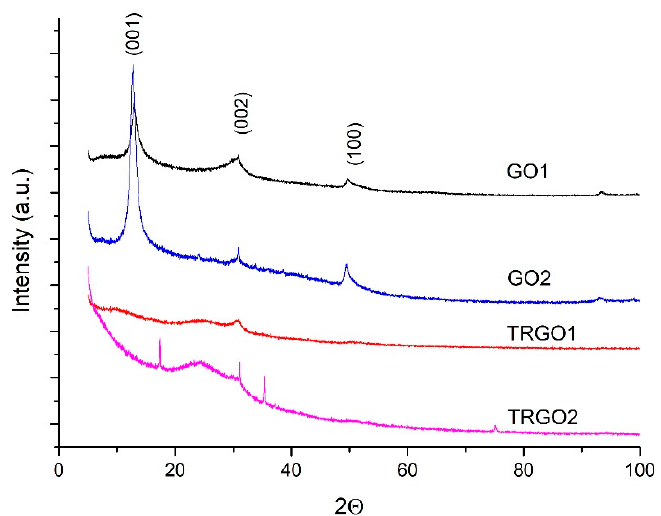
Figure A4. C1s spectra (XPS) of thermally reduced graphene oxide TRGO2.